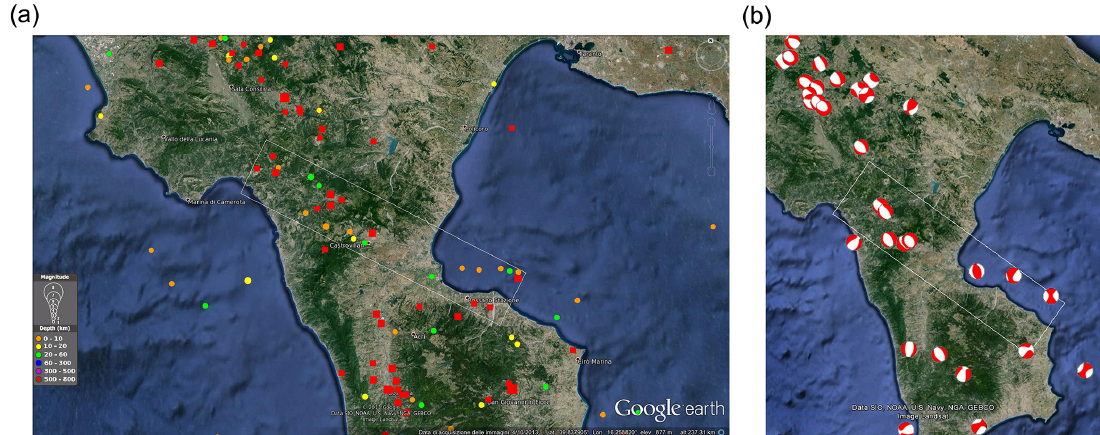
Figure 1. (a) Instrumental (full circle) and historical seismicity (red square) of the study area (earthquake with M > 4, data from UCI2001 (1960–1980), CSI (1981–2002), ITACA (2003–2005/04/15), ISIDE 2005/04/16-today and CPTI11 (1000–1959) catalogs; (b) Moment Ten- sor solutions from Global Centroid-Moment-Tensor and European-Mediterranean Regional Centroid Moment Tensor catalogs; the white rectangle in both the figures indicates the area of main